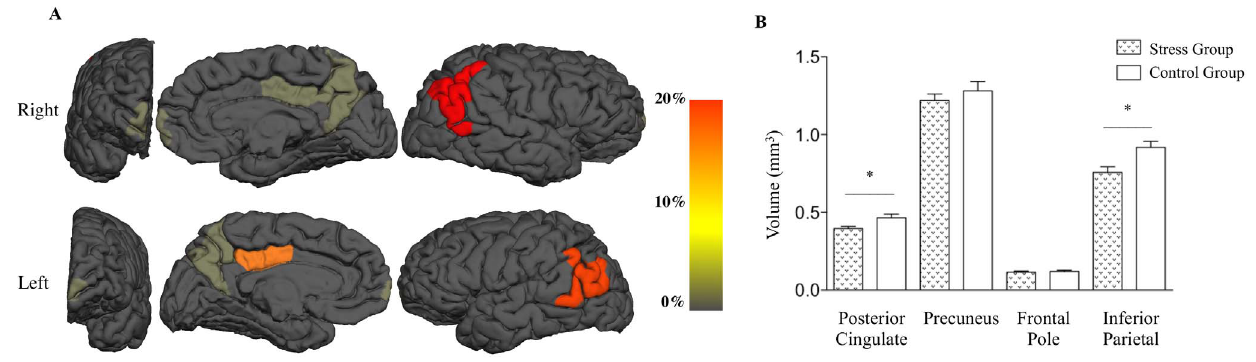
Figure 4. Volumetric Changes in the default mode network (DMN) after stress exposure. (A) Schematic representation of global DMN volumetric changes. (B) Regional volumetric differences in the DMN between Stress and Control groups. *P ,